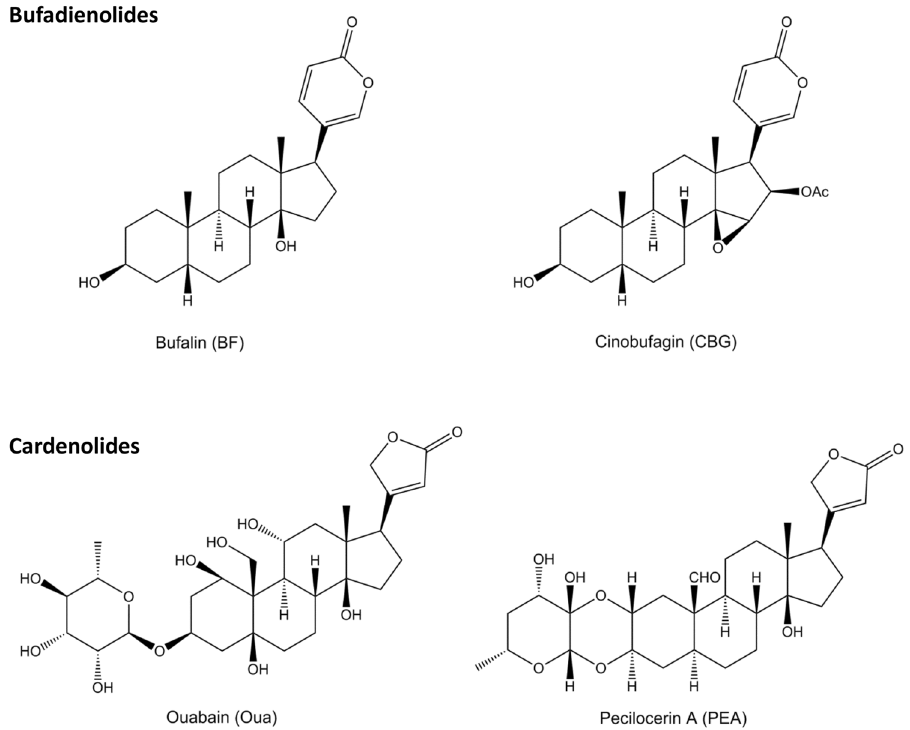
Figure 1. Structural formula of the 4 CGs adopted in the current